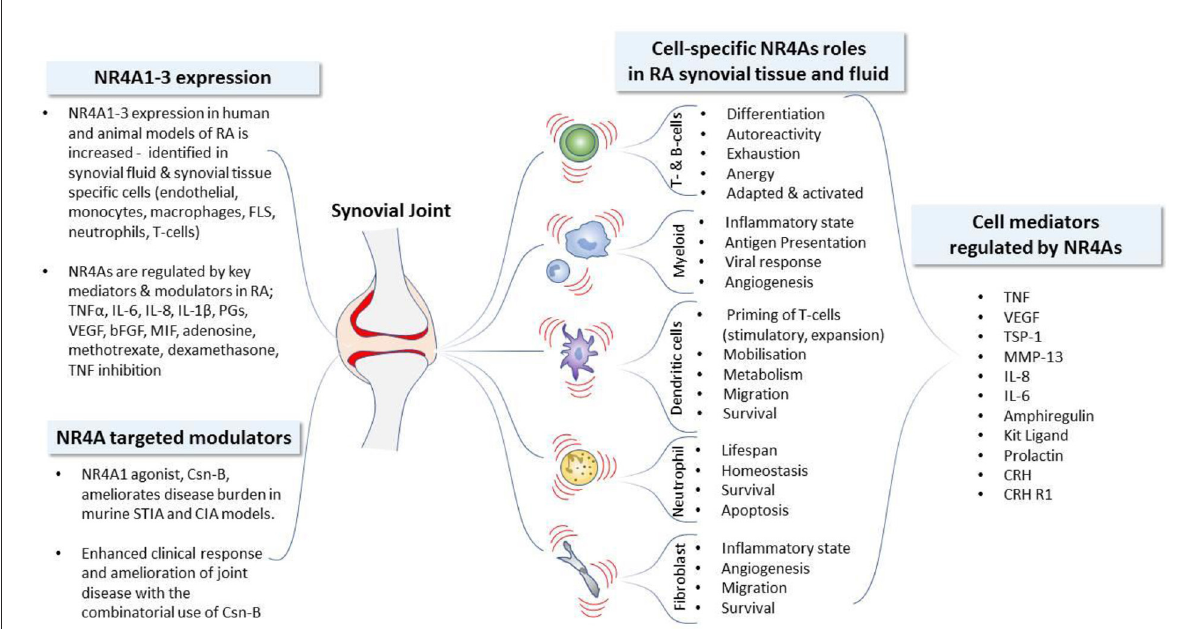
FIGURE1 NR4A nuclear receptor activity and cell-specific functions in Rheumatoid Arthritis. Development and progression of immune mediated rheumatic diseases including rheumatoid arthritis (RA) are characterized by dysfunction of resident stromal fibroblast-like synoviocytes (FLS), innate and adaptive immune cell populations. The loss in cellular and tissue homeostasis culminates in a pro-inflammatory microenvironment leading to the advancement of chronic inflammation and disease progression. The expression profile of NR4A receptors identified in human and animal models of RA, together with the established mediators known to regulate NR4A receptor expression, are depicted. The functional activities of NR4As in synovial tissue and fluid is similarly cell-type dependent: NR4As regulate the synthesis and release of mediators to control angiogenesis, modulate the regulatory and invasive functions of resident FLS, alter the activation and tolerogenic status of dendritic cells, control homeostasis and the lifespan of neutrophils, influence the generation and responses of peripheral myeloid, B- and T-lymphocyte lineages and promote the maintenance of functional regulatory T-cells. The efficacious use of the NR4A1 modulator, Csn-B, reveals the therapeutic potential of NR4A receptors in models of RA with significant amelioration of disease activity. bFGF, basic fibroblast growth factor; CIA, collagen induced arthritis; CRH, corticotropin releasing hormone; CRH-R1, corticotropin releasing hormone receptor 1; Csn-B, cytosporone-B; FLS, fibroblast-like synoviocytes; KL, Kit ligand (also called SCF, stem cell factor); MIF, macrophage migration inhibitory factor; MMP, matrix metalloproteinase; PG, prostaglandin; IL, interleukin; STIA, serum transfer-induced arthritis; TSP-1, thrombospondin-1; TNF, tumor necrosis factor; VEGF, vascular endothelial growth